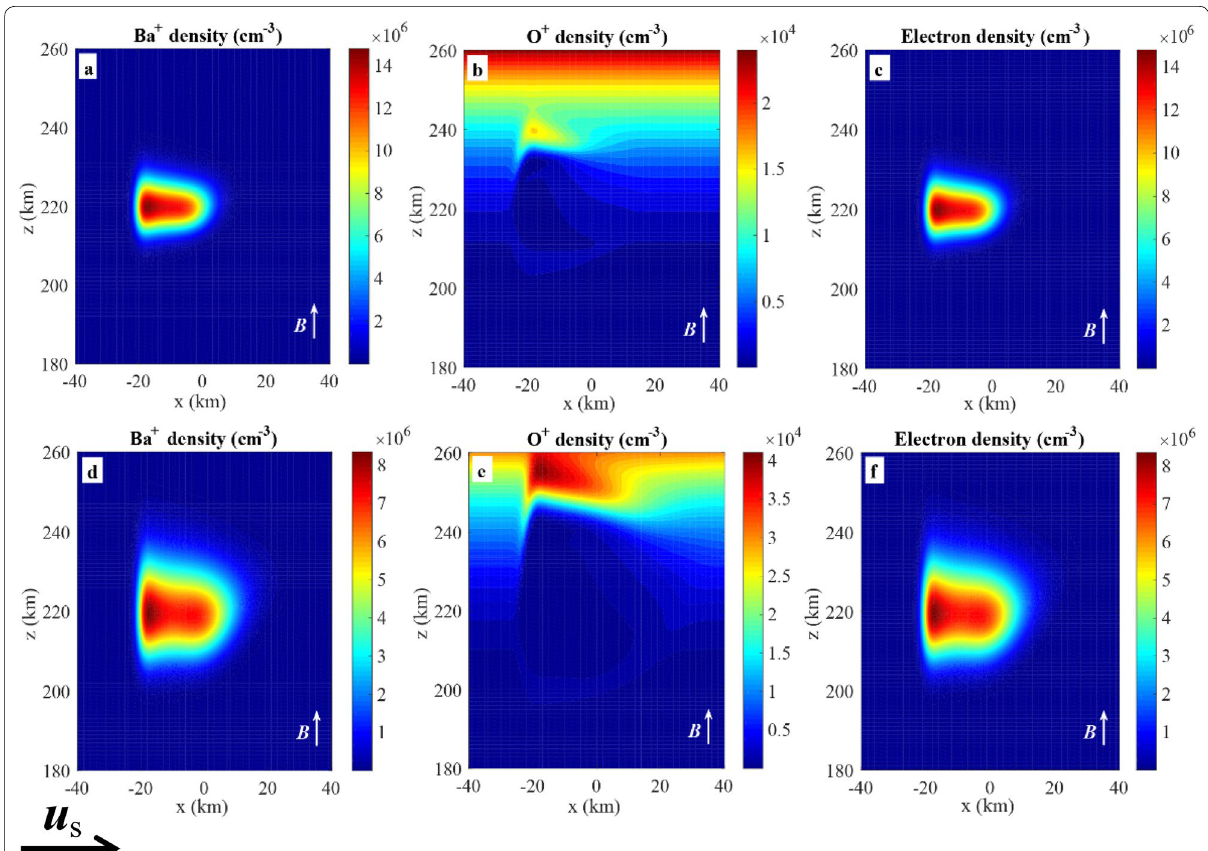
Fig. 7 The plasma cloud distribution in the x–z plane at t u s is 2 km/s perpendicular to